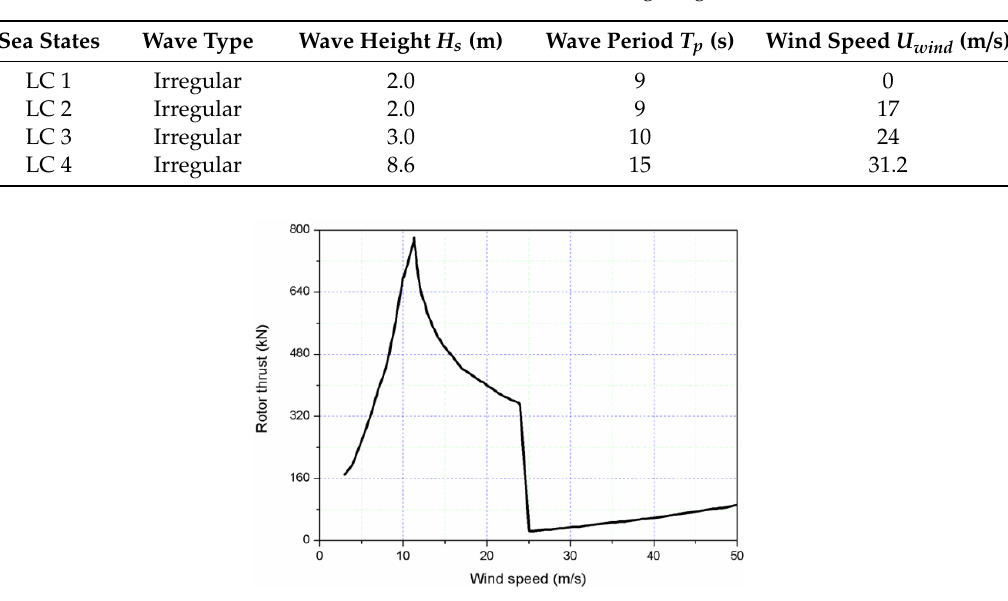
Figure 14. Rotor thrust curves at different wind speeds.